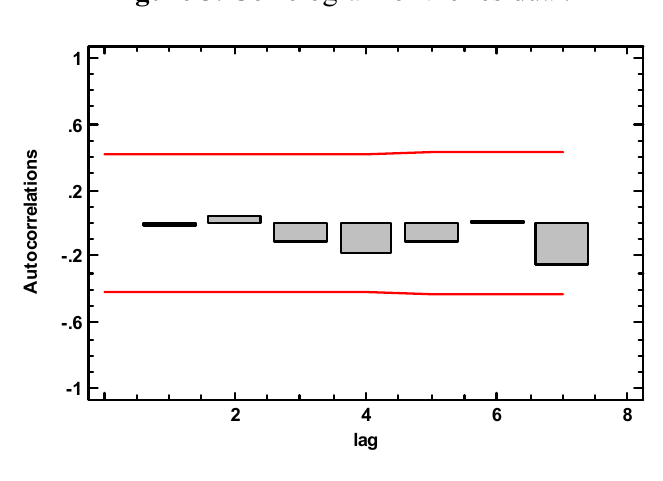
Figure 3. Correlogram of the